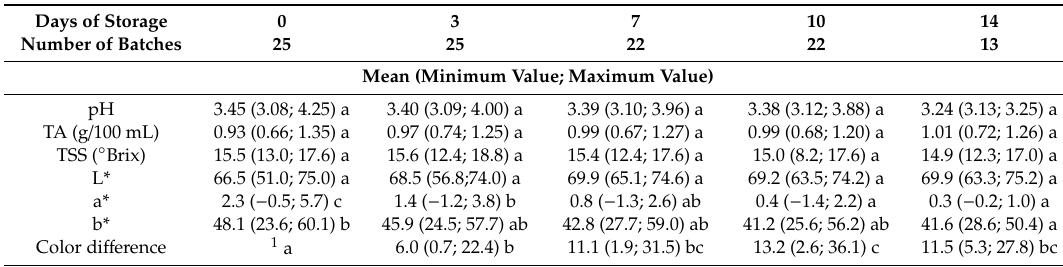
Table 4. Physicochemical parameters of untreated pineapple juice during storage at 4 ◦ C. For the same line, di ff erent letters indicate significant di ff erence.